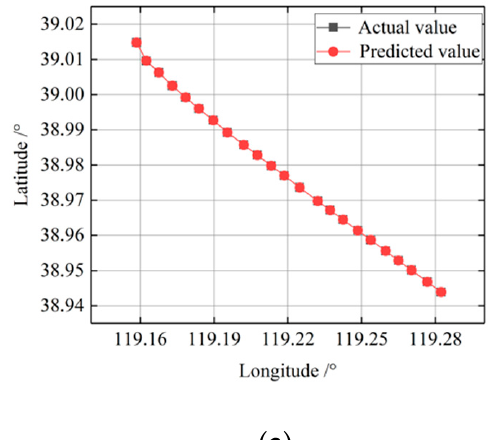
Figure 12. Prediction results of e-trajectory using the ACDE-SVR model. ( a ) Comparison of predicted and actual values of e-trajectory; ( b ) Longitude and latitude absolute error values of e-trajectory.